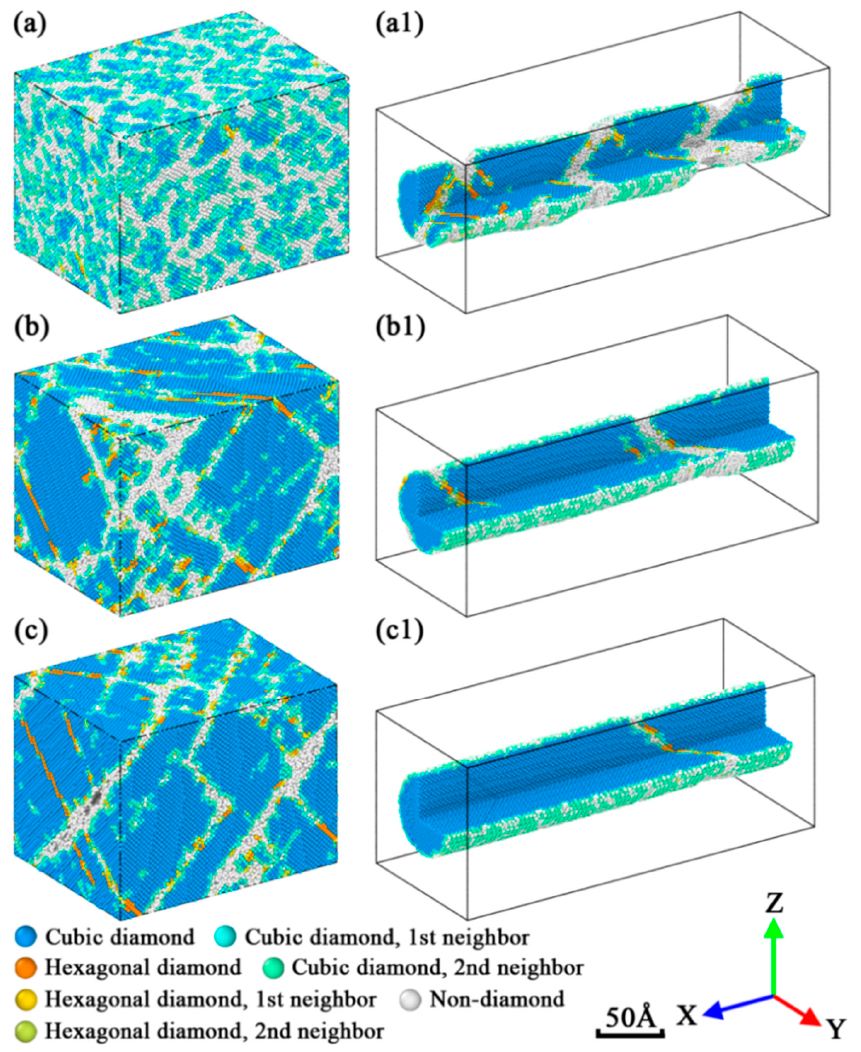
Figure 4. Cleavage fracture of Mono-Si under three strain rates: ( a ) 10 − 2 /ps; ( b ) 10 − 4 /ps; ( c ) 10 − 6 /ps. Slip fracture of SiNW under three strain rates: ( a1 ) 10 − 2 /ps; ( b1 ) 10 − 4 /ps; ( c1 ) 10 − 6 /ps. The SiNWs were sliced to reveal their inherent structures.